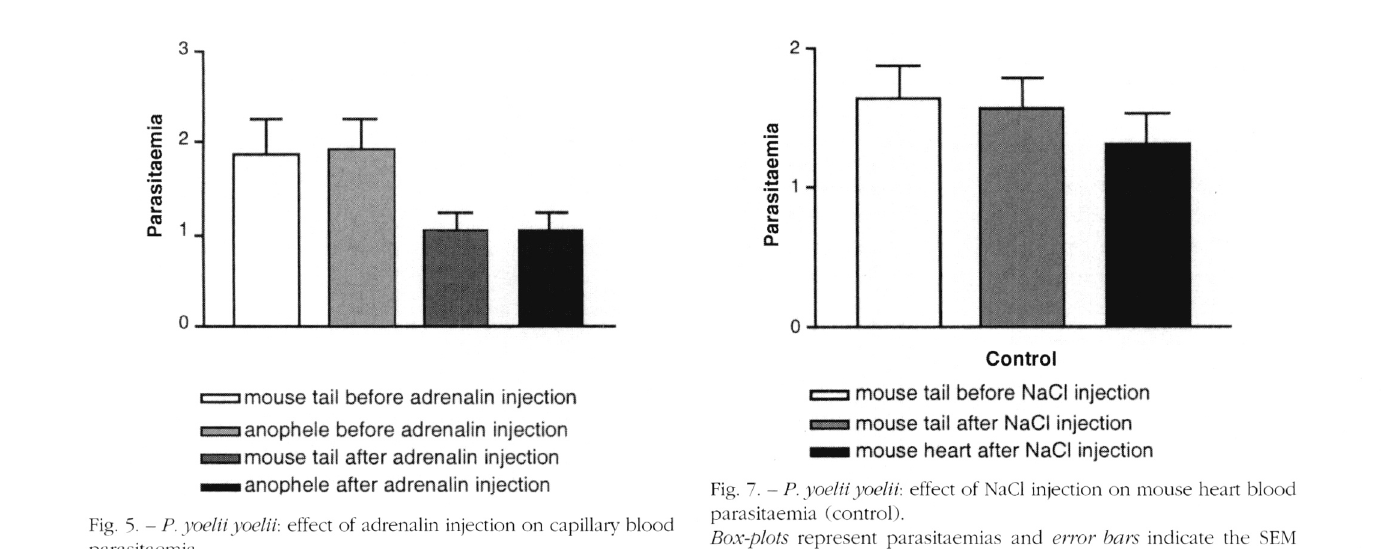
Box-plots represent parasitaemias and error bars indicate the